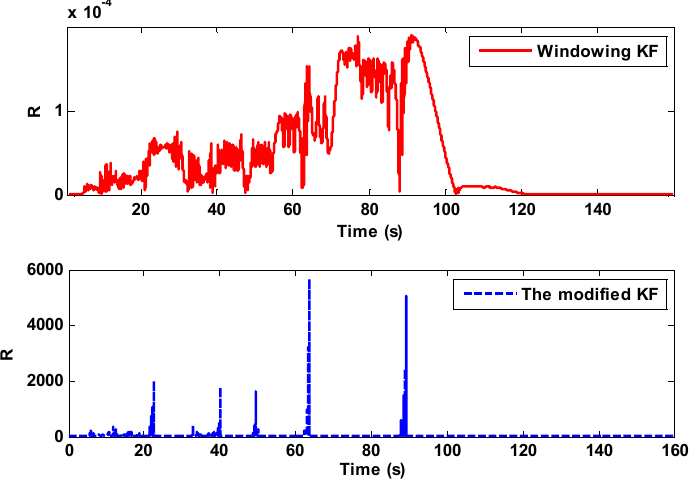
Figure 10. Comparison for updating R for proposed KF methods (for voltage angle signal).